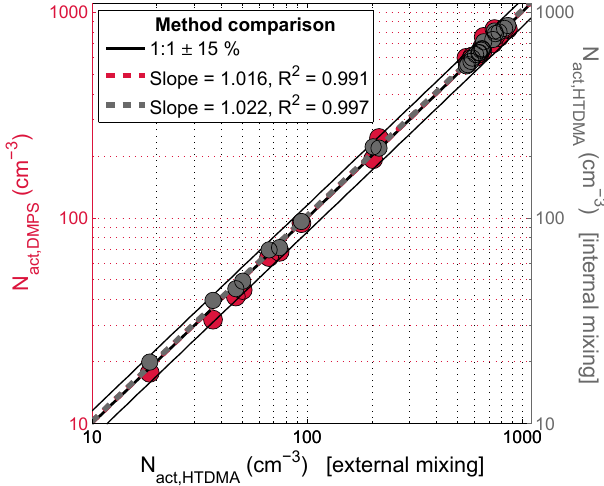
Figure 4. Correlations between the estimated (HTDMA) and mea- sured (DMPS) cloud droplet concentrations (red dots) and the ex- ternal and internal mixing approaches (grey dots). Each data point represents an hourly